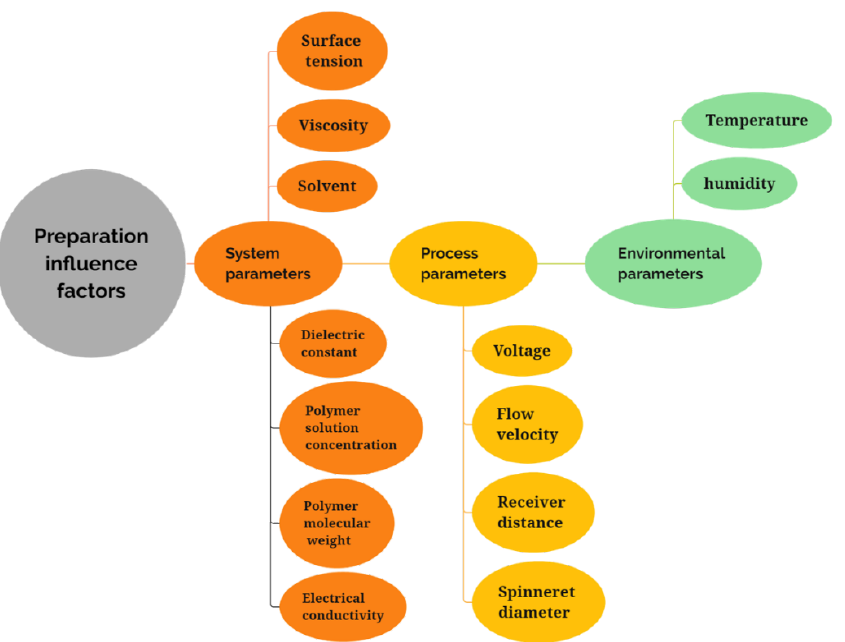
Figure 3. Influencing factors, environmental parameters, process parameters, and environmental parameters of the electrospinning process.